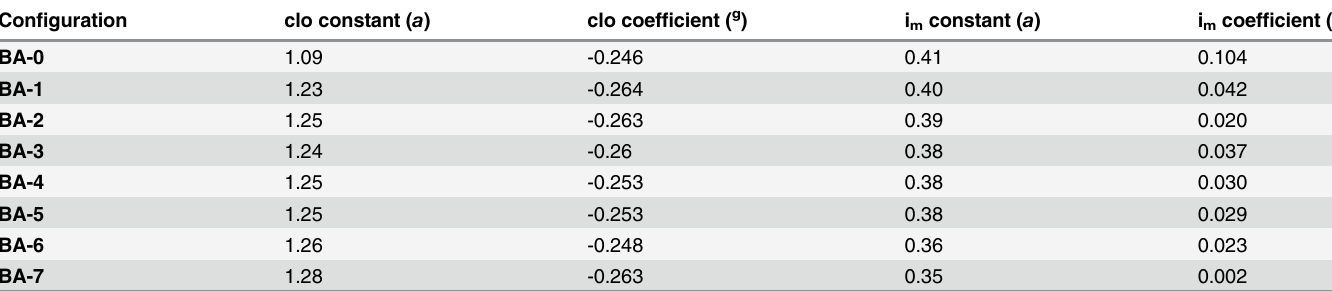
Table 3. Wind velocity coefficient values ( V g ) for each